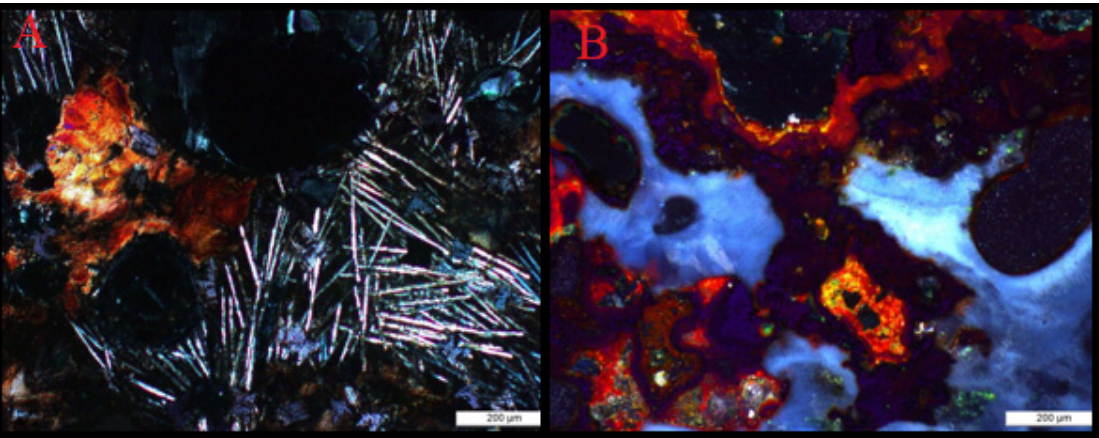
Figure 5. Microphotographs of slags with visible devitrified glaze ( A ) and iron oxides and hydroxides located in the background of the glaze and voids ( B ).